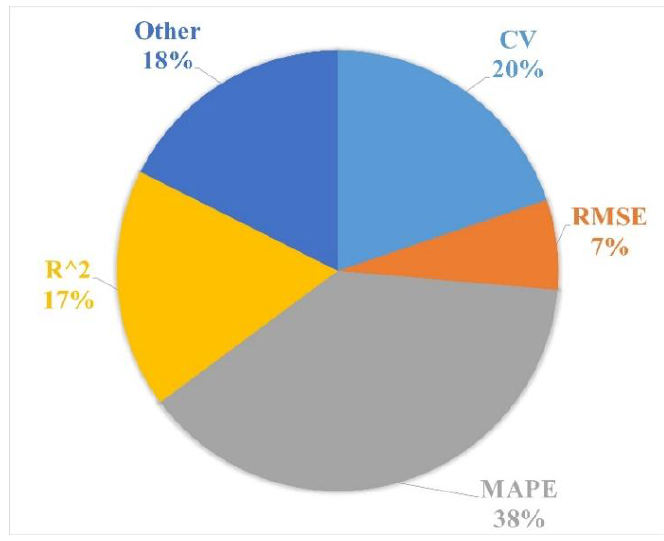
Figure 12. Breakdown of performance measures applied. CV—coefficient of variation; RMSE—root- mean-square-error; MAPE—mean absolute percent error.